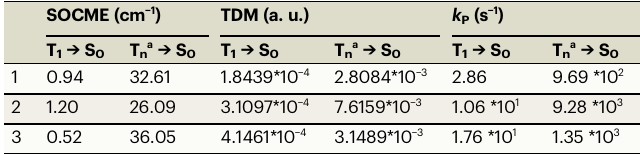
Table 5 | Calculated SOCME (cm − 1 ), transition dipole moments (TDM, a.u.), and phosphorescence emission rate ( k p , s − 1 ) of 1 – 3 based on optimized triplet excited states geometries at the ω B97X-D3/def2-TZVP(-f) level of theory